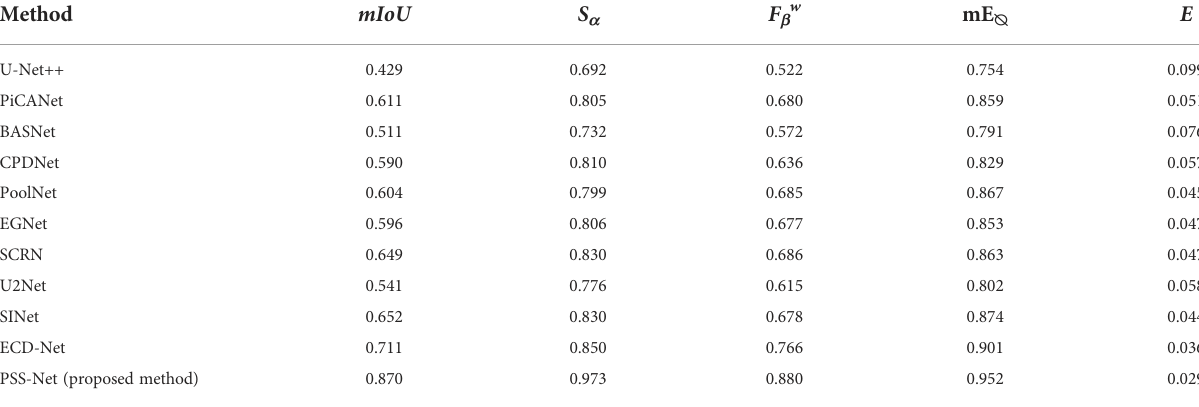
TABLE 4 Comparison of proposed PSS-Net and state-of-the-art methods with MAS3K dataset (case 1). Method